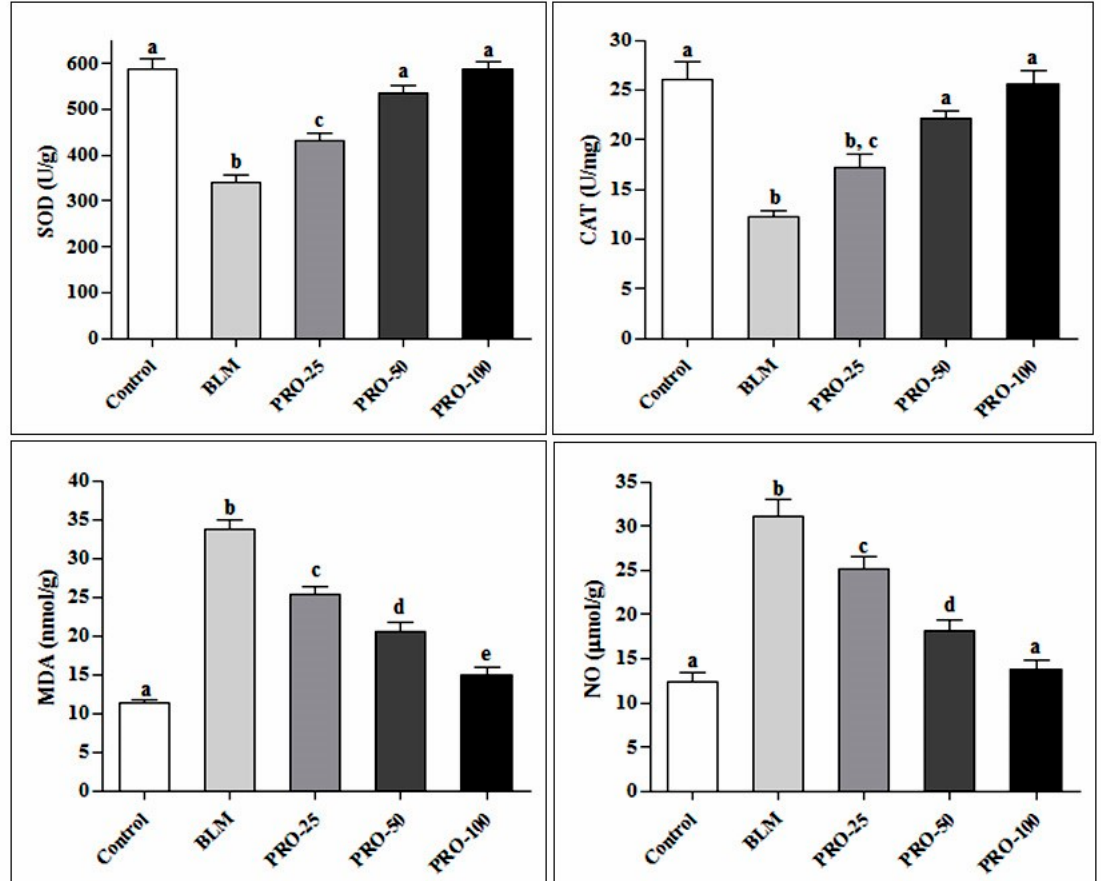
Figure 2. Effect of the PRO on oxidative stress markers (SOD, CAT, MDA, and NO) in lung tissue homogenate of BLM-treated mice. Different superscripts refer to significance at p ≤ 0.05 ( n = 6).